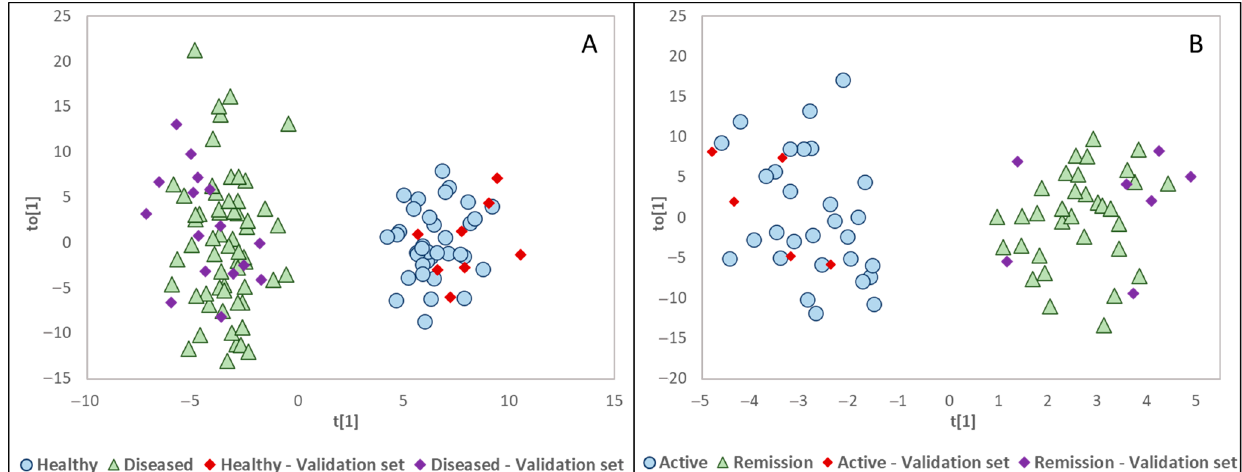
Figure 6. ( A ) Score ‐ plots of binary OPLS ‐ DA model using UV scaling to discriminate between serum of diseased and healthy IBD volunteers. ( B ) Score ‐ plots of binary OPLS ‐ DA model using normalized data with respect to RIP intensity and UV scaling to discriminate between serum of IBD diseased patients in active or remission stage.